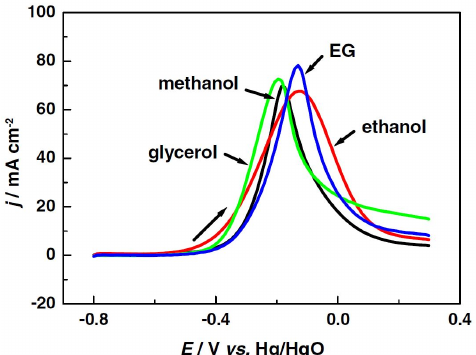
Figure 6. Linear potential sweep curves of the oxidation of methanol, ethanol, glycerol and ethylene glycol on the as-prepared three-dimensional Pd/(carbonized porous anodic alumina) electrode in 1.0 M alcohol/1.0 M KOH solution, 303 K, scan rate: 50 mV s − 1 . Reprinted